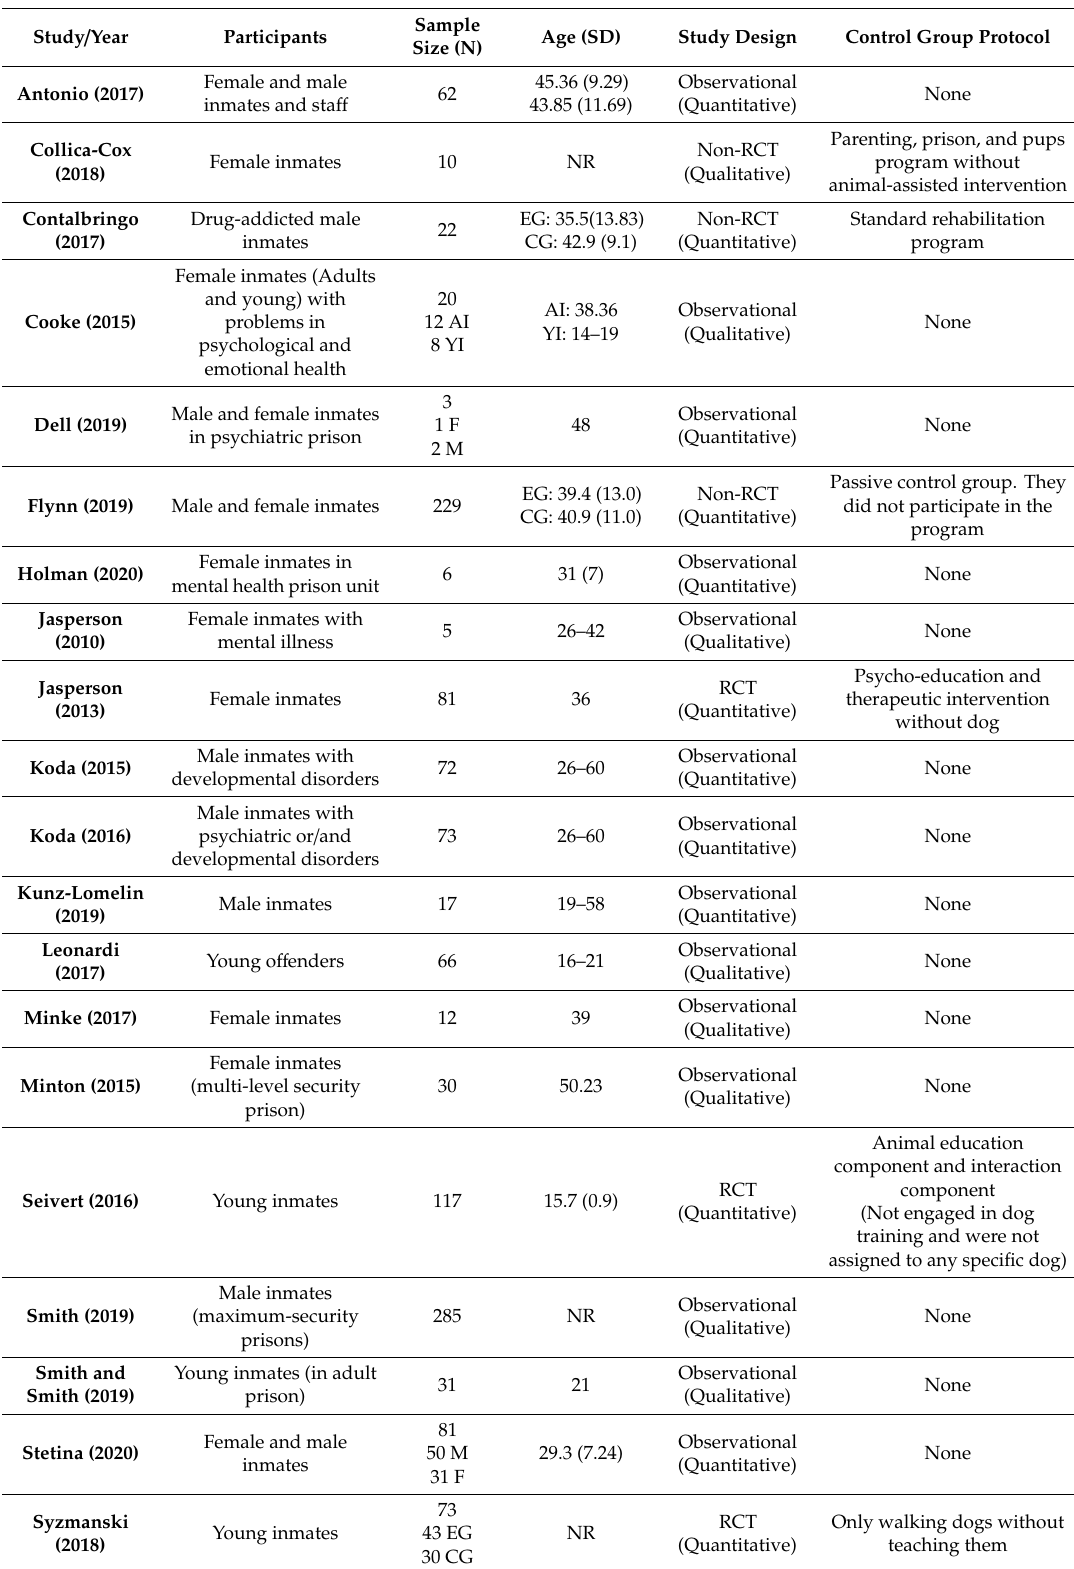
Table 2. Characteristics of the sample and the